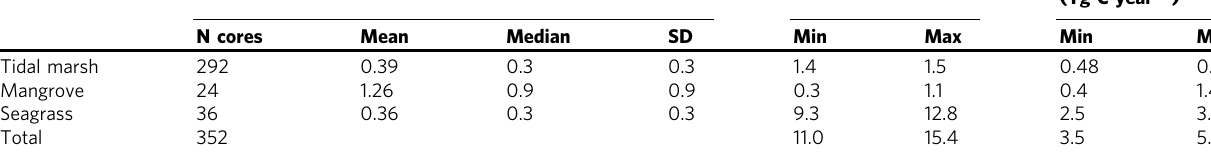
Tropical, Subtropical, Desert, Grassland and Temperate, but the number of climate regions was reduced into fi ve categories: Tropical (includes Equatorial), Subtropical, Arid (instead of Desert), Semi-arid (instead of Grassland) and Temperate. b Spatial distribution of tidal marsh 25 , mangrove 26 , and seagrass 28 ecosystems within Australia. c Organic carbon stocks in living aboveground biomass and soils (in the top meter), and C sequestration rates per unit area (Mg C ha − 1 ) and across Australia (Tg C). The stacked bars represent the maximum and minimum estimates (s.d.).